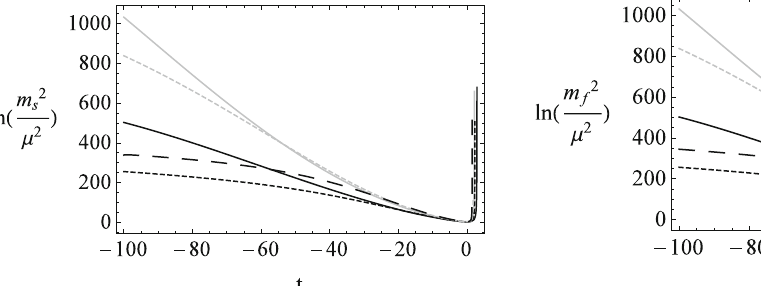
Fig. 11 The running of induced ln ( G / G ∗ ) , ln ( M 2 /μ 2 ) and ln ( M 2 /ωμ 2 ) in left, centre and right respectively. These are plotted for f 2 ∗ = 10 − 8 , λ ∗ = 0 . 2 (black solid line), 0 . 25 (black short-dashed